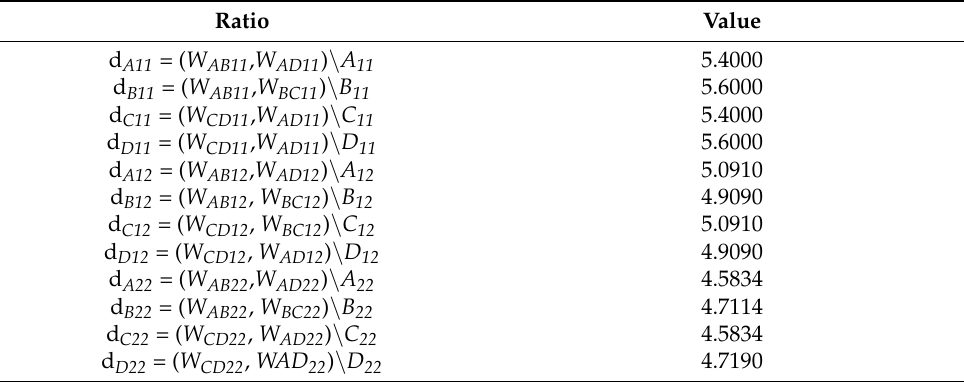
Table A4. The division coefficients employed to calculate the coordinates of the Bv and Ω vertices for i, j = 1,